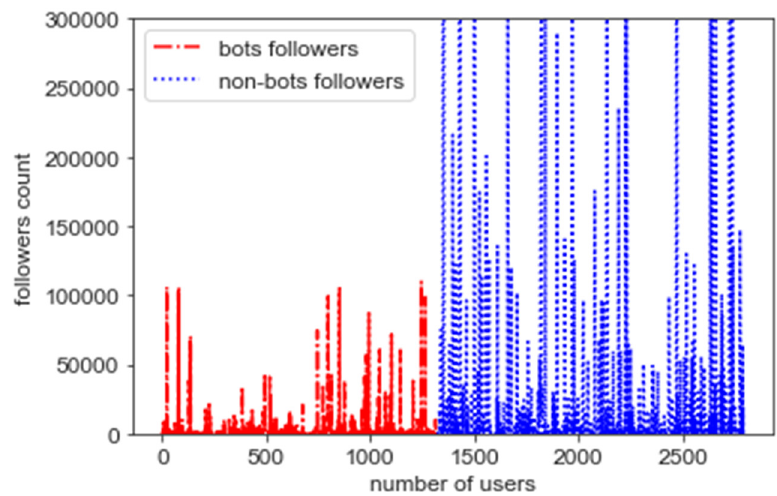
Figure 14. Numbers of Users against follower count.